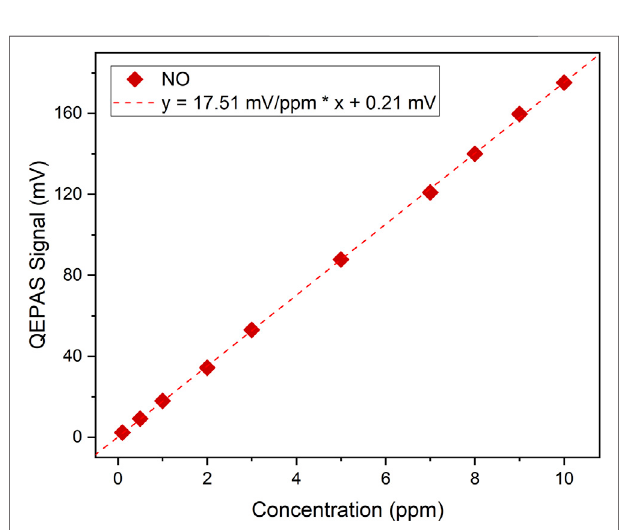
Frontiers in Environmental Chemistry |